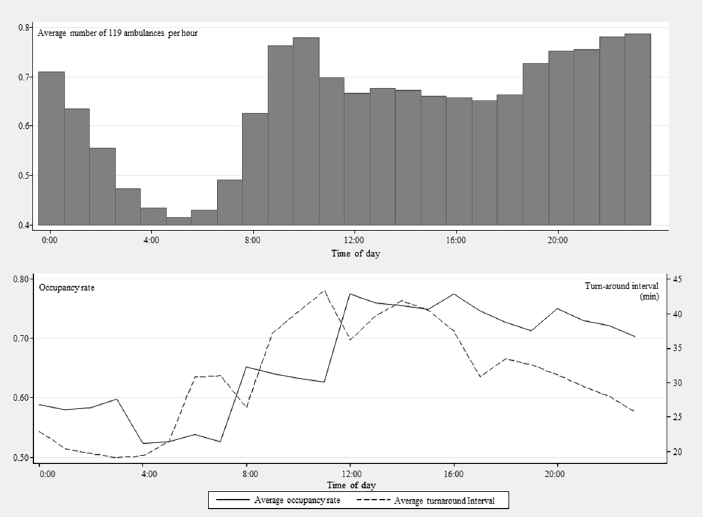
Fig 3. Circadian variation in emergency department overcrowding and ambulance turnaround time. During daytime, overcrowding and turnaround time increase